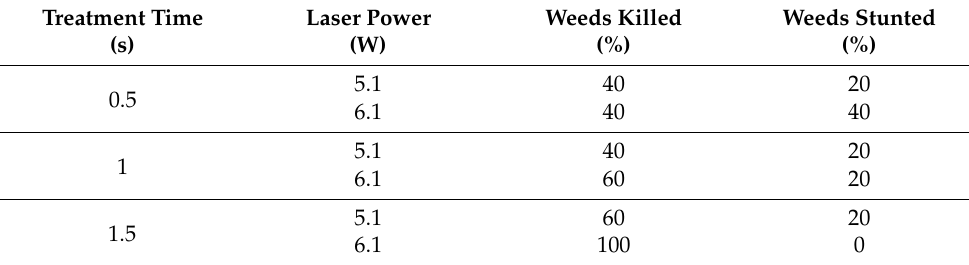
Table 3. Percentage of weeds killed or stunted after 1